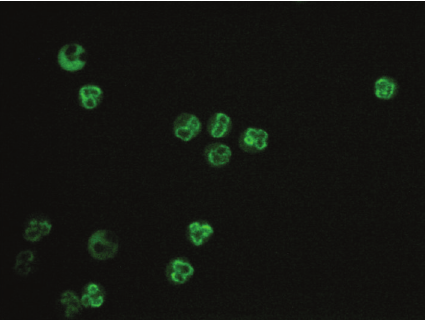
Table 2: ANCA in the IgG and IgA